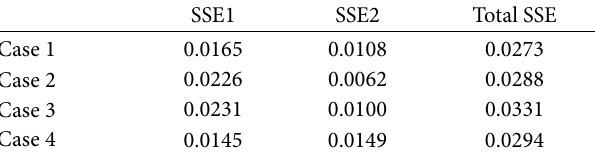
Table 5: Posterior inference for parameters of